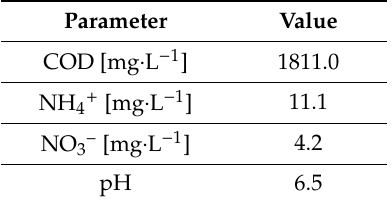
Table 2. Parameters of wastewater applied for measurements.